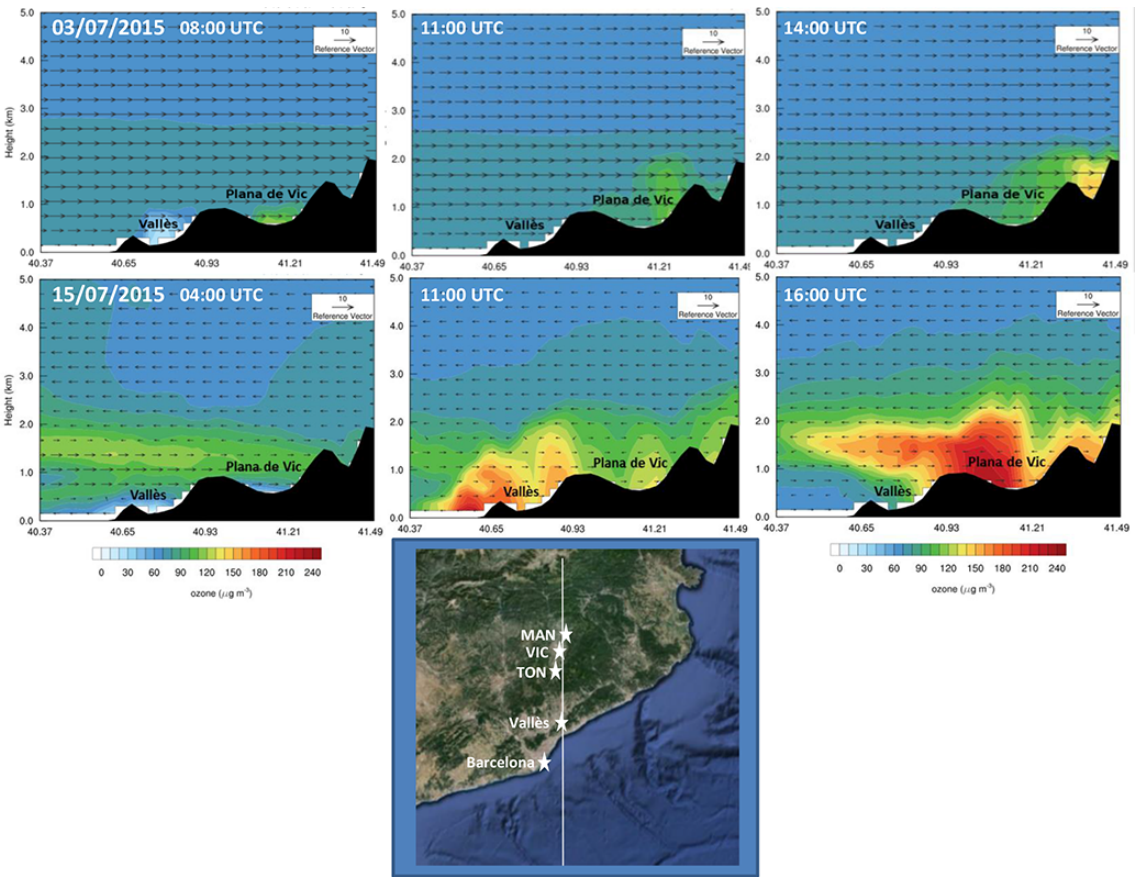
Figure 17. Spatial distributions of simulated O 3 concentrations and wind field vectors in the south–north vertical cross-section for different hours on 3 and 15 July